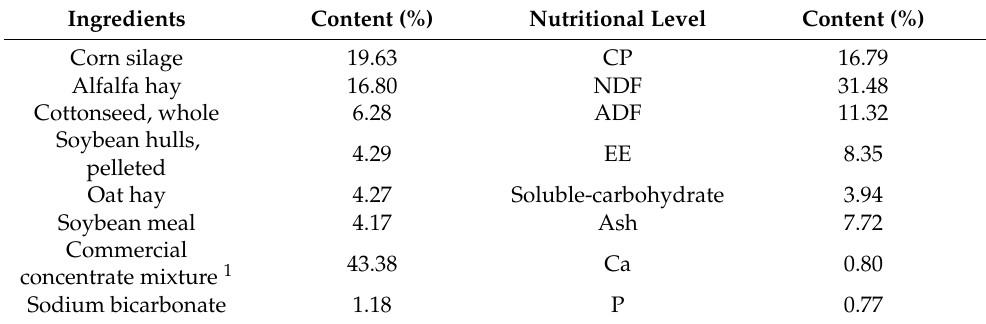
Table 1. Ingredient and chemical composition of the diet during the experiment (DM